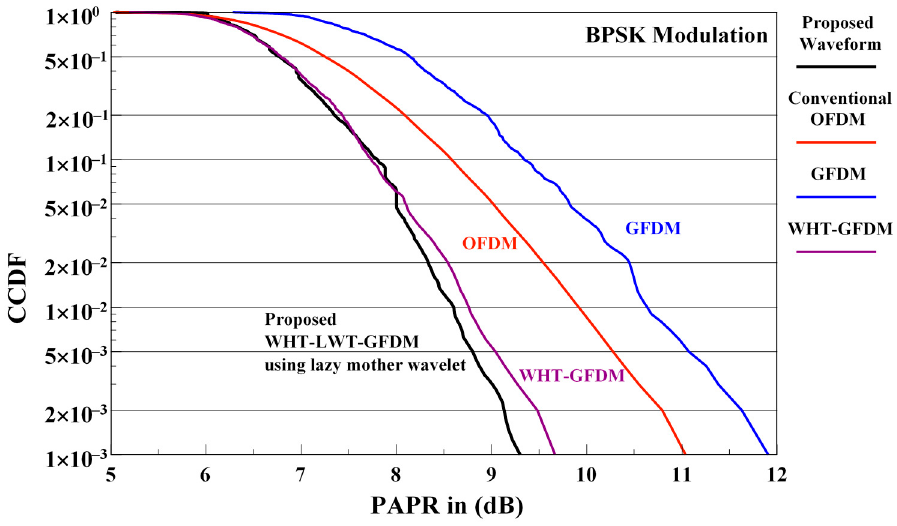
Figure 10. The PAPR performance comparison of the conventional OFDM, GFDM, WHT-GFDM, and WHT-LWT-GFDM waveforms.